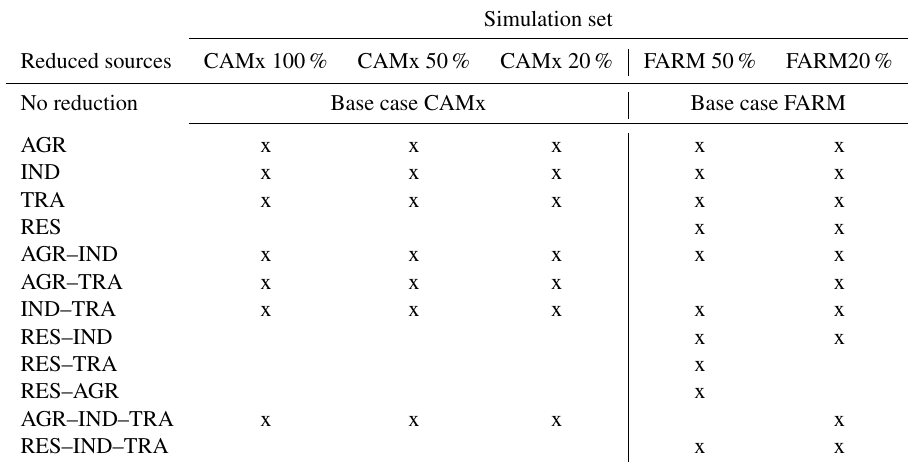
Table 2. Sets of simulations performed in this study to compute the factor decomposition (Stein and Alpert, 1993). Every set is named after the used CTM and ERL.